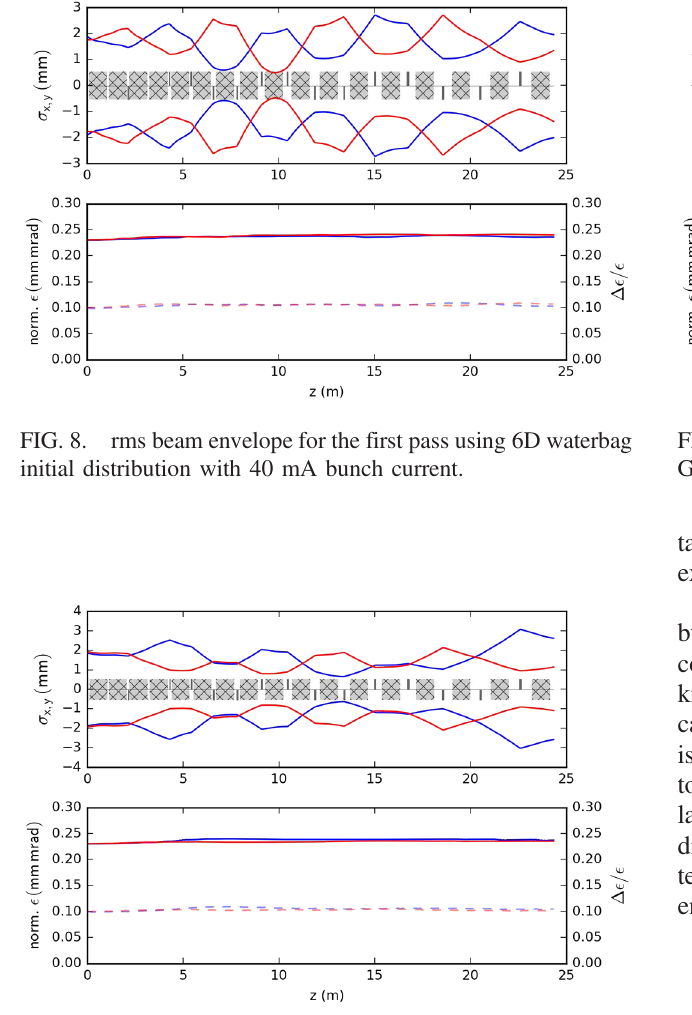
FIG. 9. rms beam envelope for the second pass using 6D waterbag initial distribution with 40 mA bunch current.